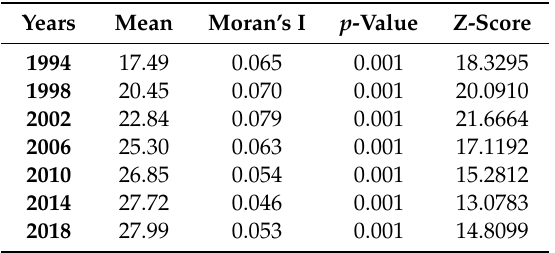
Table 1. Clustering statistics of global Moran’s I for women’s descriptive representation in Czech local councils,